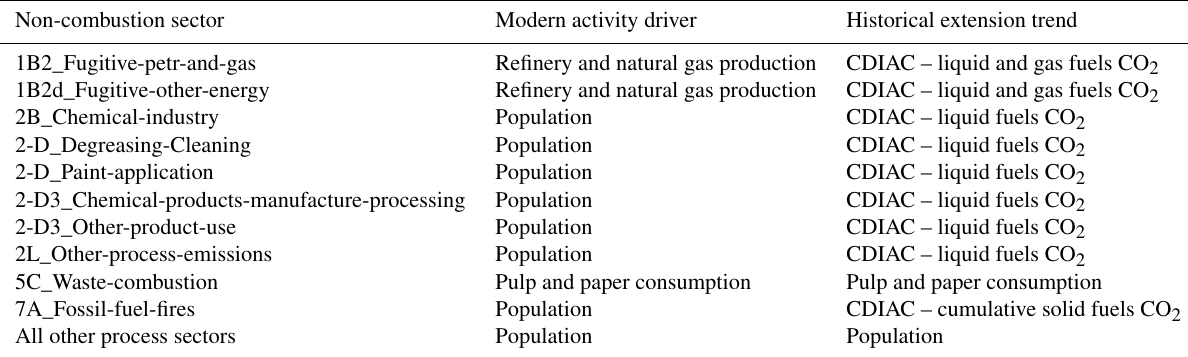
Table 4. Historical driver extensions for non-combustion